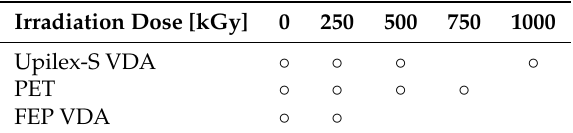
Table 1. The investigated electron irradiation doses for each of the 3 different polymer foil